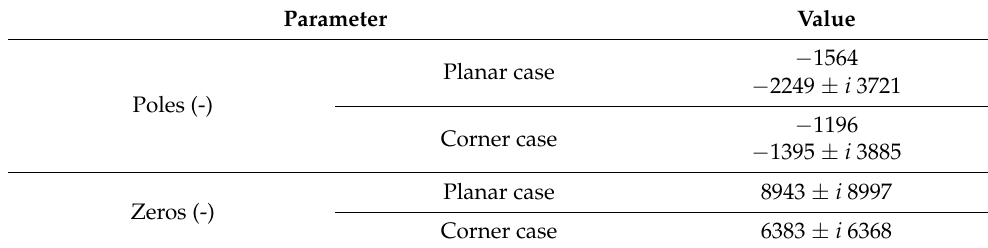
Table 3. Poles and zeros of modelled transfer functions.